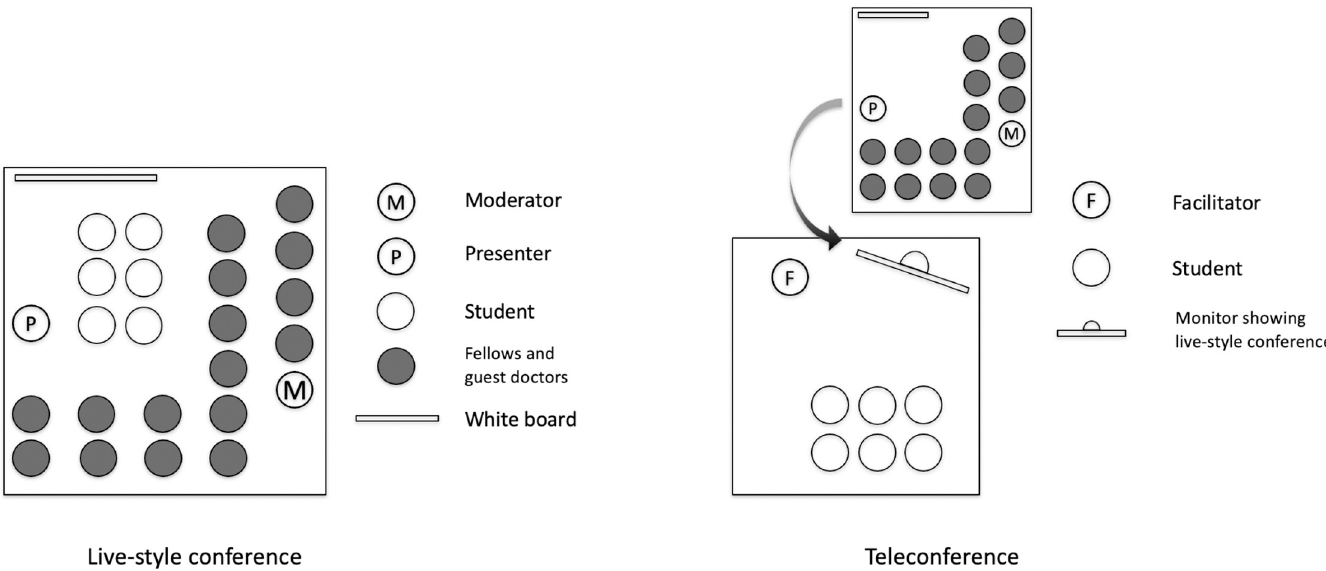
Fig 1. Traditional live-style conference and learner-centered approach teleconference.